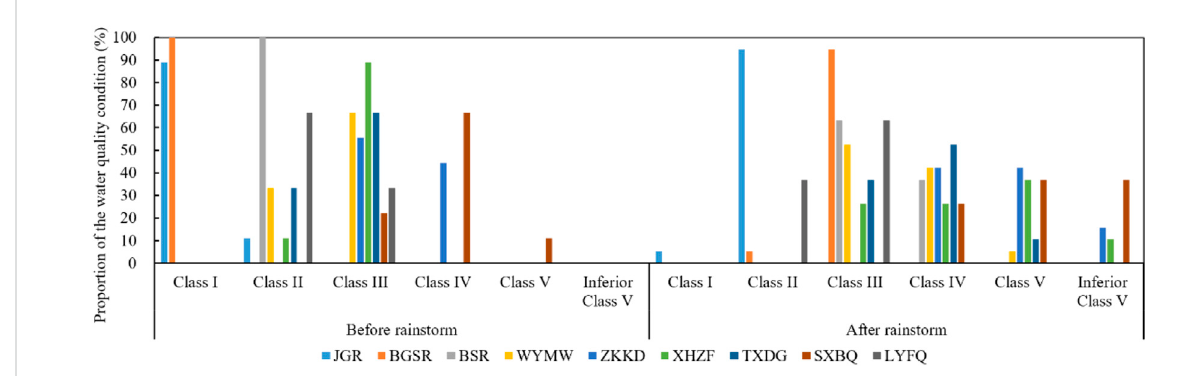
FIGURE 8 The distribution of the I Wq of each monitoring section before and after the rainstorm.